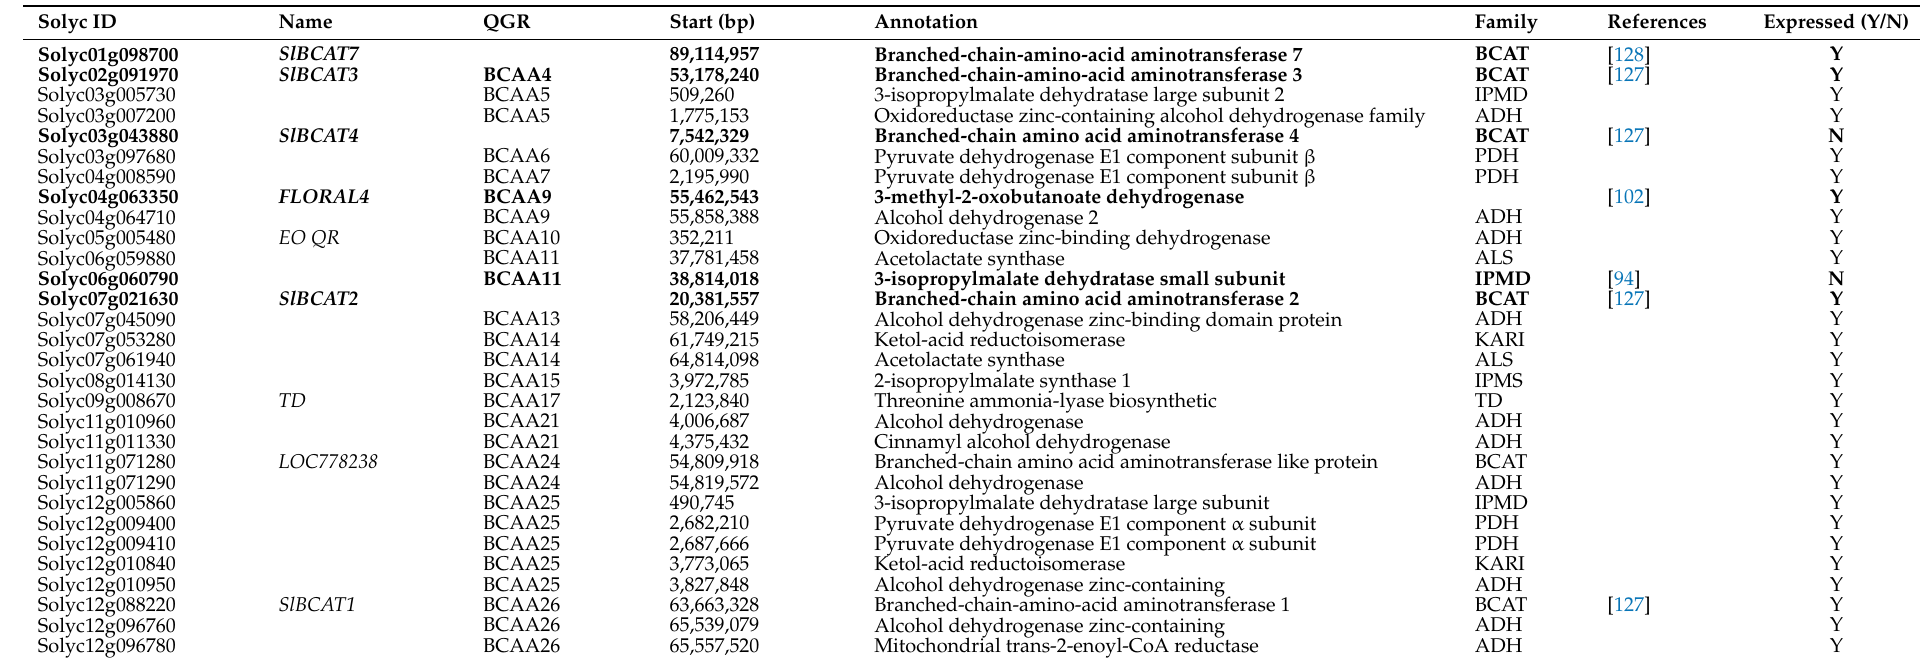
Table 4. List of the genes identified as potentially responsible for the BCAA VOCs QTL reported in literature. Genes that have been functionally characterized are highlighted in bold in the table. The last column reports whether the gene has been reported to be expressed in fruit (Y/N—[103]); for a complete overview of the gene expression see Table